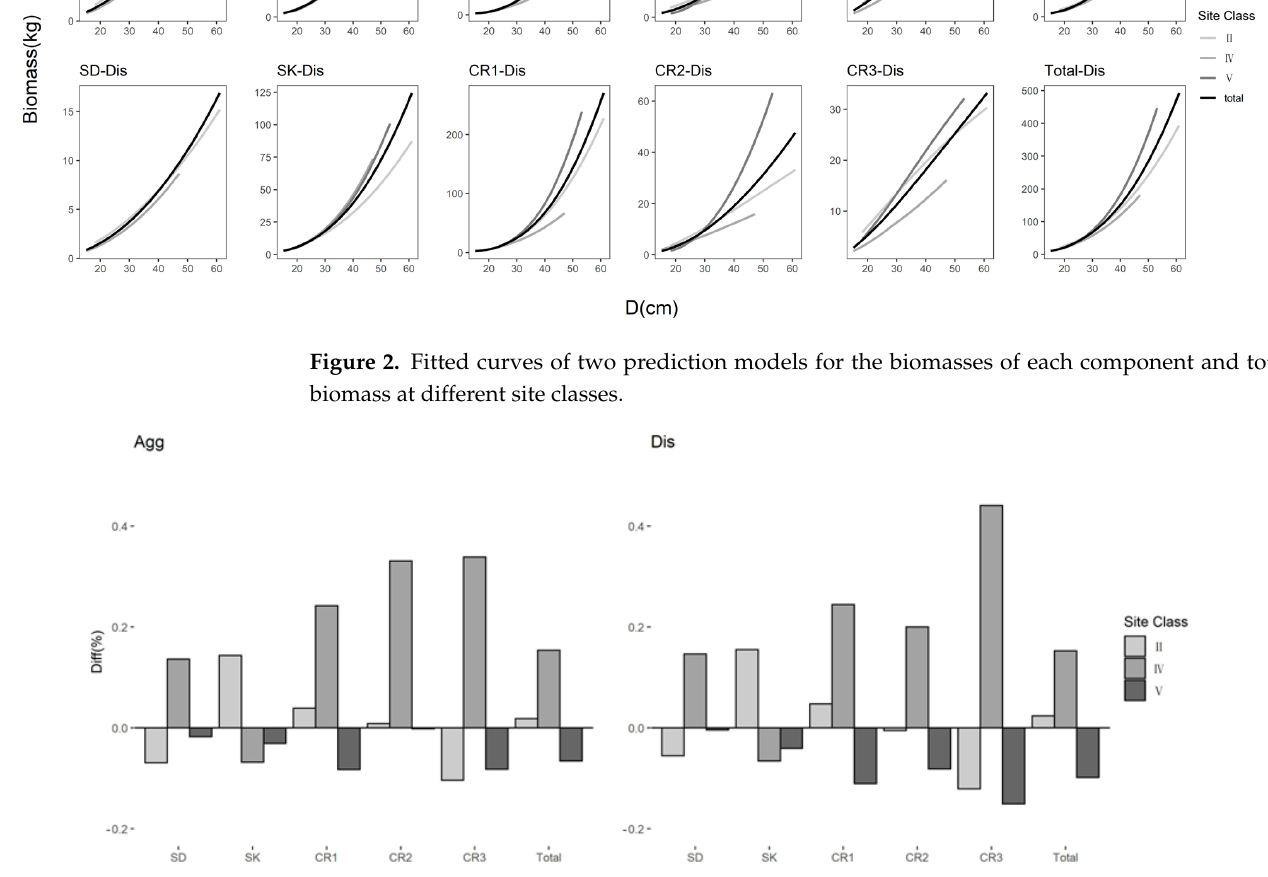
Figure 3. Comparison of values obtained for total biomass and component biomass using a generic and a specific model ( Diff ).